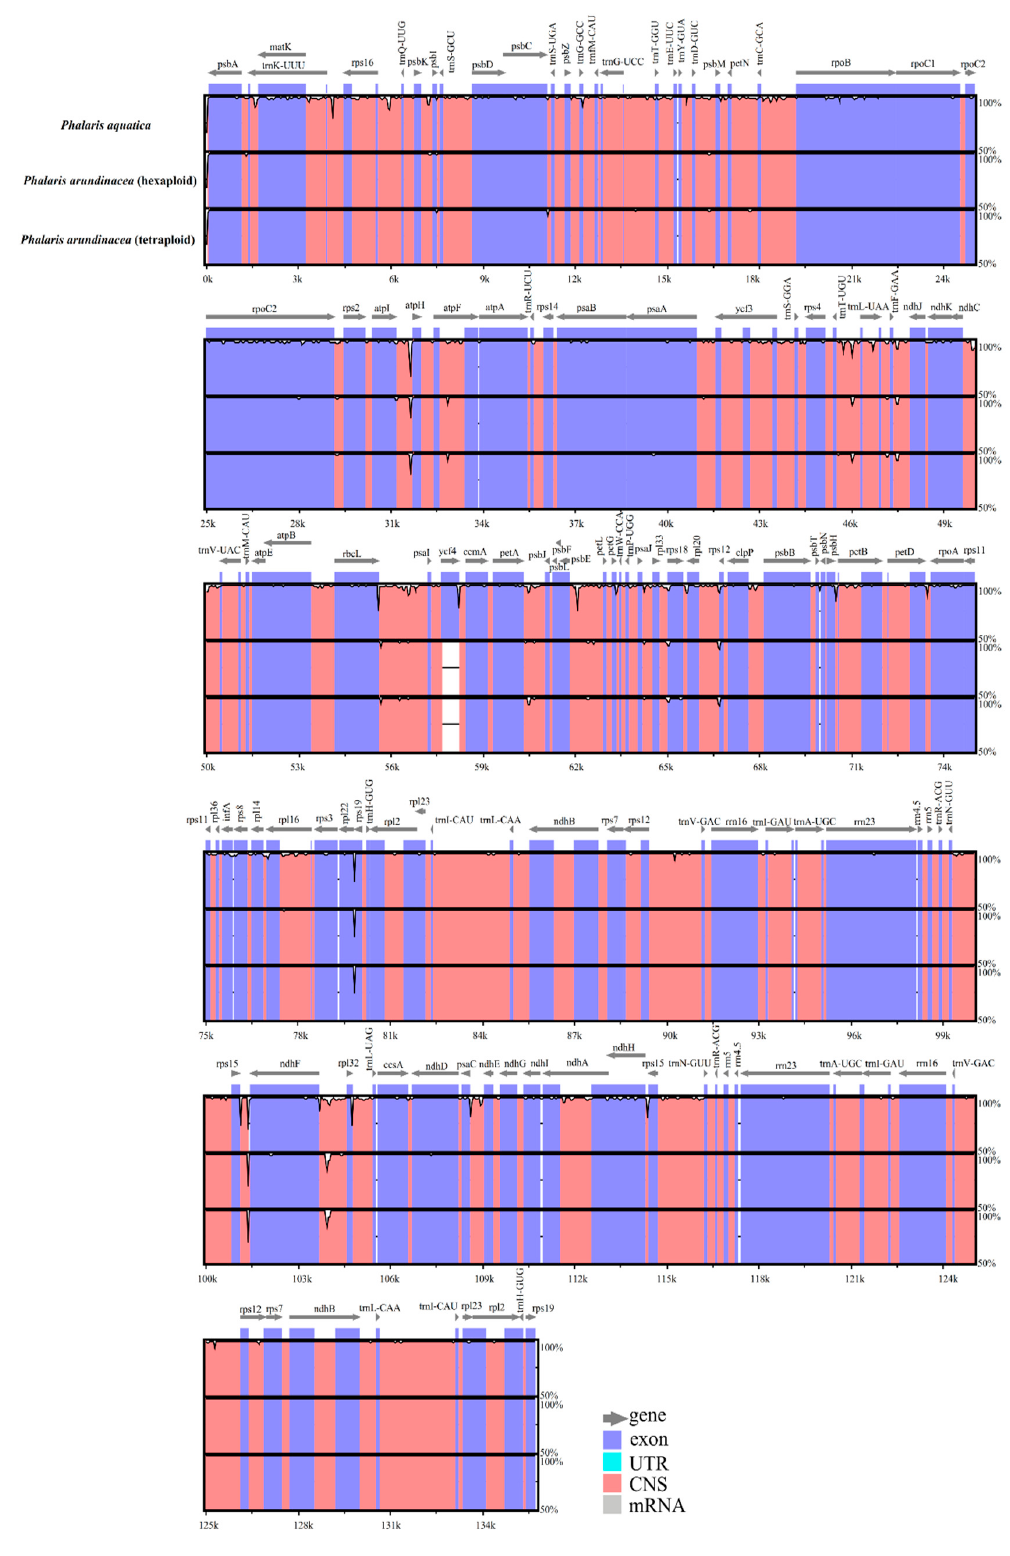
Figure 2. Alignment of the Phalaris chloroplast genome sequences. Exon, untranslated region (UTR), conserved noncoding sequences (CNS), and mRNA were color-marked. The x -axis and horizontal bars represent the coordinate and sequences similarity in the chloroplast genome, and the peaks indicate hotspot regions.